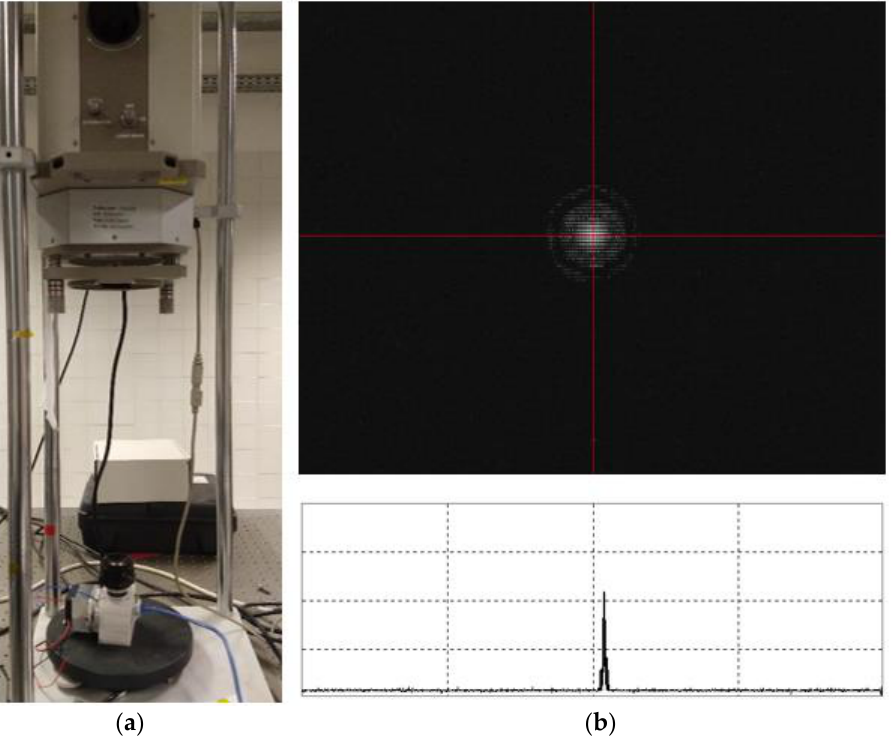
Figure 5. Camera in the interferometer ( a ); image of the light beam focused on the sensor with a horizontal intensity per pixel cut shown ( b ).